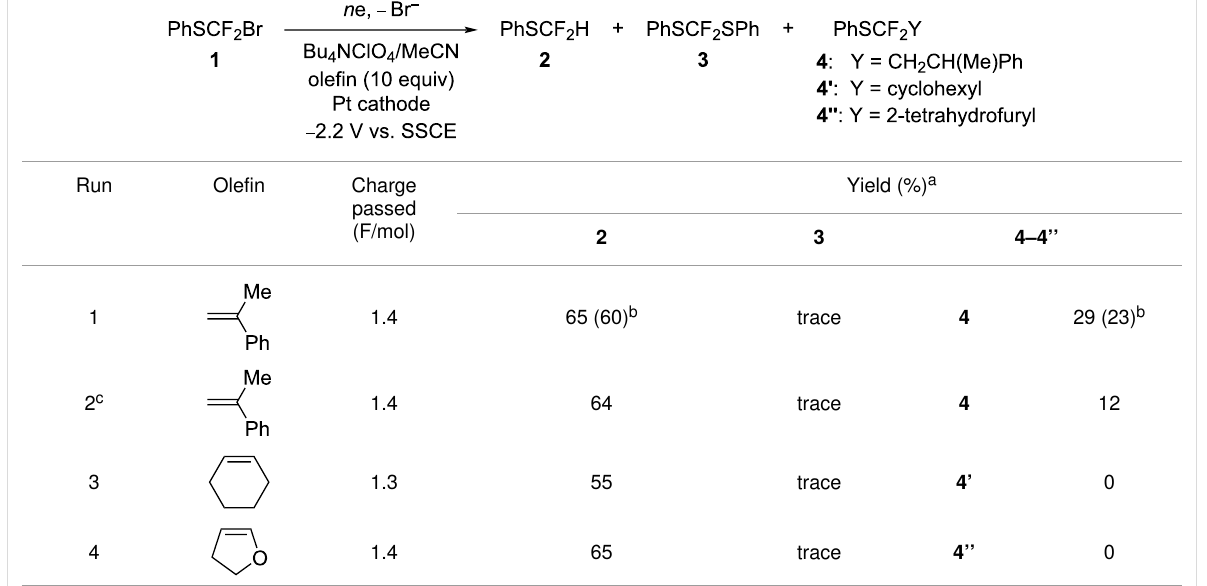
generate radical species selectively, indirect cathodic reduction using various mediators has been often employed. Médebielle et al. successfully carried out the cathodic reduction of ArCF 2 X and RCOCF 2 X with nitrobenzene as a mediator to generate the corresponding difluoromethyl radicals selectively, and they applied this electrocatalytic system to the synthesis of various heterocyclic compounds bearing a perfluoroalkyl or perfluo- roacyl group [27-30]. Furthermore, they extended this method- ology to tandem cyclization to provide fused difluoro- methylene-containing heterocycles [31]. In consideration